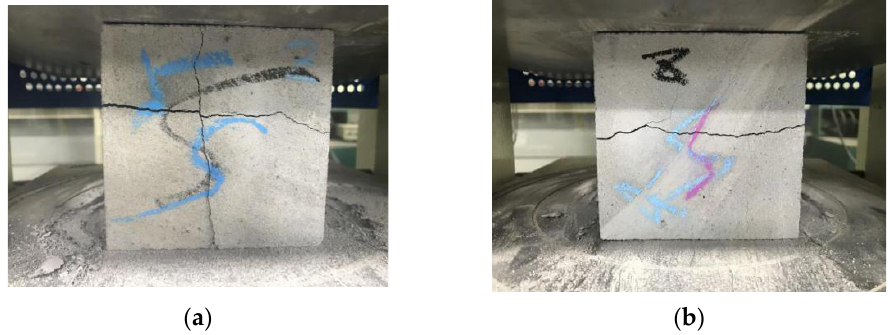
Figure 15. The printed cube sample cracks of ( a ) B plane and ( b ) reverse plane.